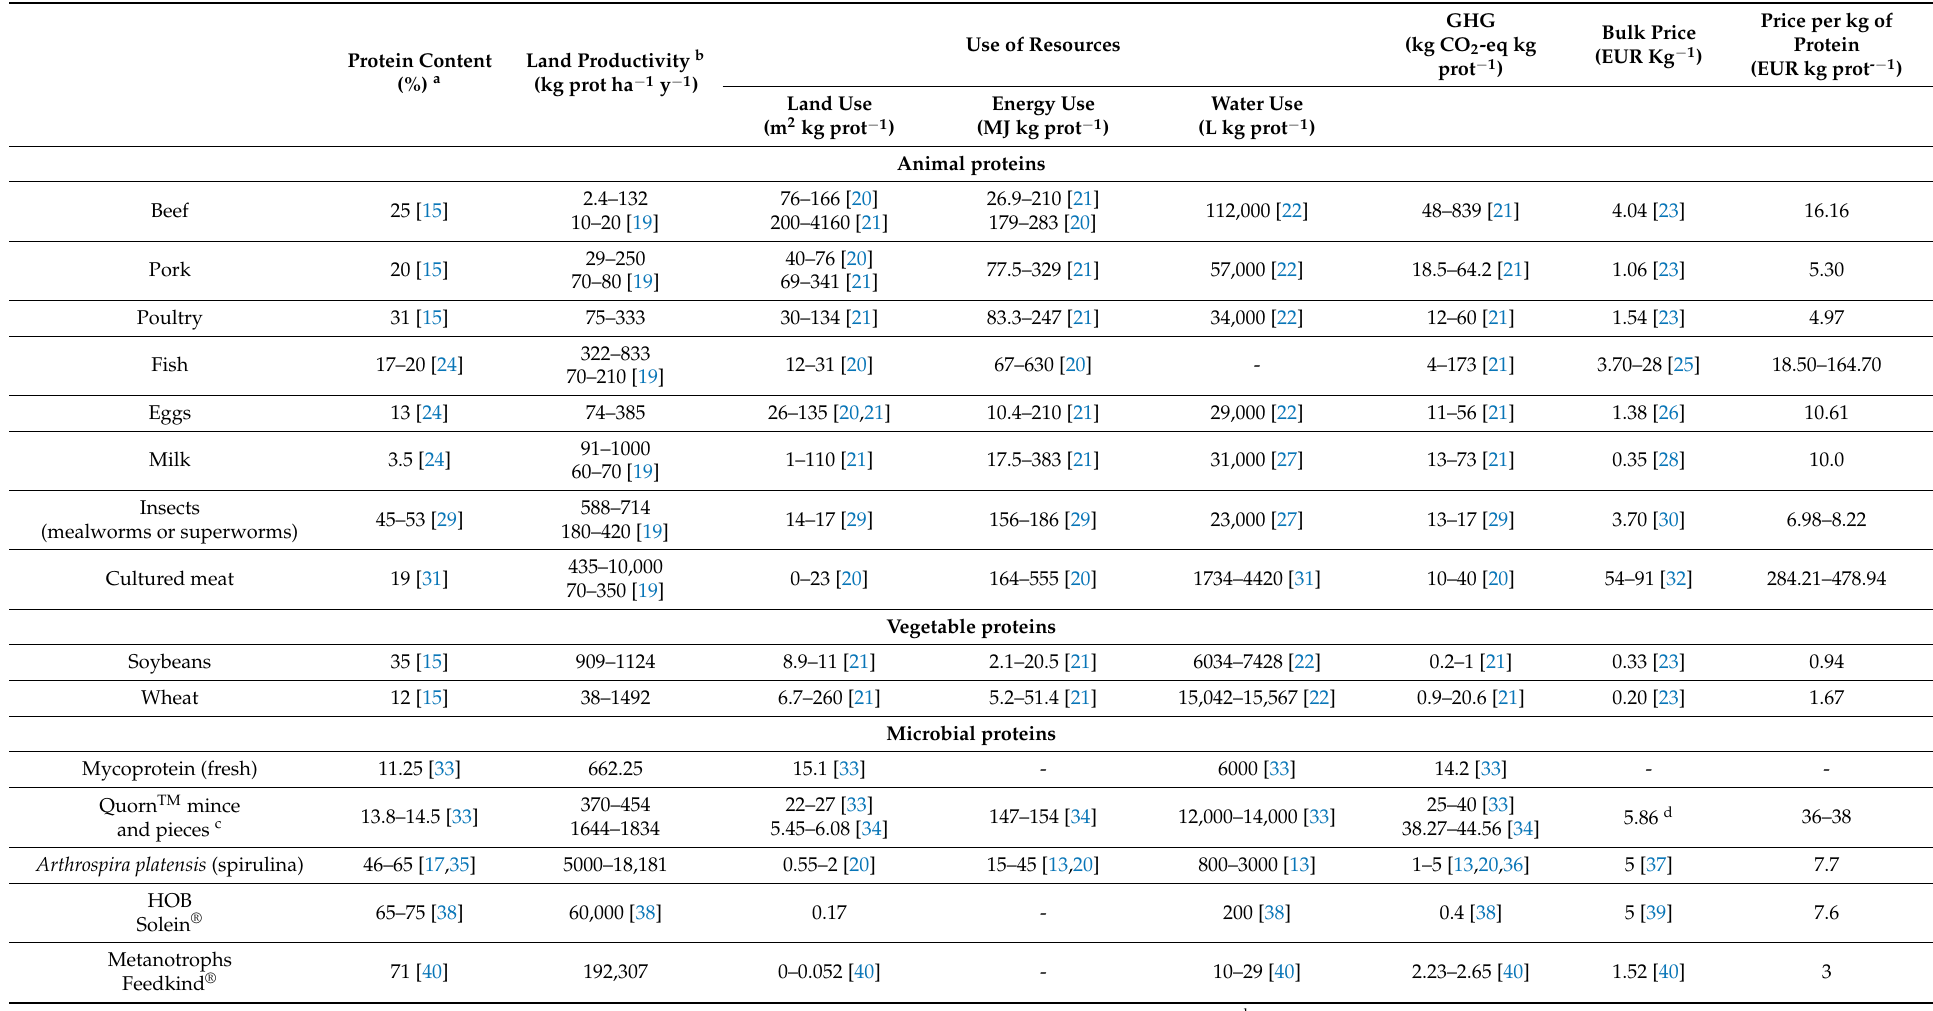
Table 1. Protein content, productivity, use of resources, GHG emissions of traditional and innovative protein